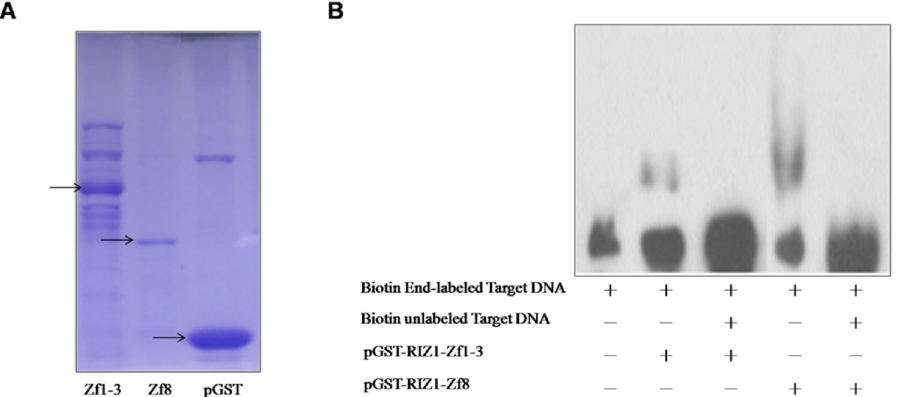
Figure 4. Binding to Akt3 promoter by recombinant RIZ1 protein fragments. ( A ) Shown is a Coomassie Blue stained gel of partially purified GST fusion proteins of RIZ1 containing zinc finger motifs 1–3 and 8 (pGST-RIZ1-Zf1–3 and Zf8). The arrow from left to right pointed to the protein bands of Zf1-3, Zf8 and pGST respectively. ( B ) EMSA results. EMSA was performed using purified pGST-RIZ1-Zf1-3 and Zf8 fusion proteins and biotin end labeled probes of Akt3 promoter region CpG146. Un-labeled probes (30 fold excess) were used in competition